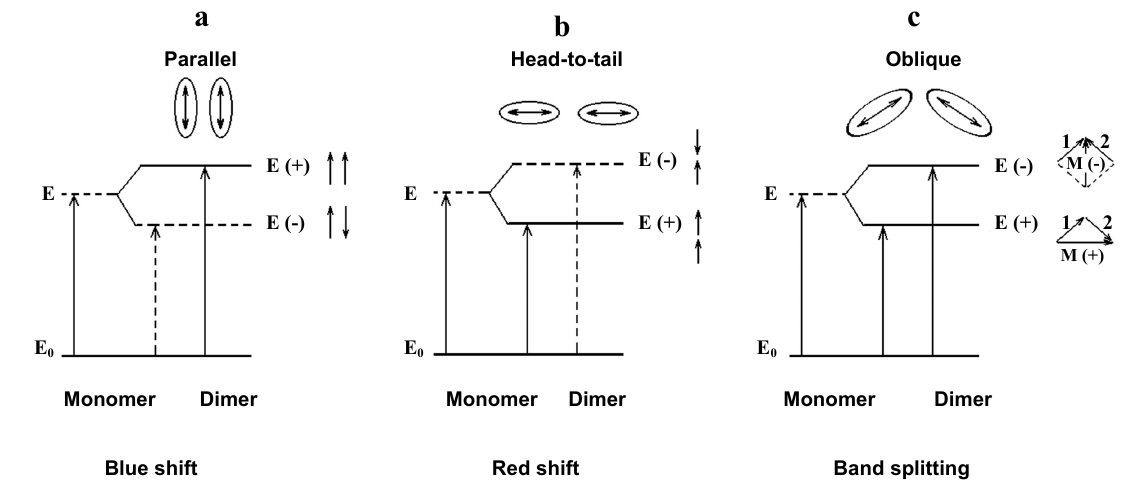
Figure 11. System of electronic energy levels and transitions from ground to excited state for dimers of different configurations: ( a ) “sandwich structure”, ( b ) “head to tail”, ( c ) location of molecules at some angle—”tree type”. Dotted arrows and lines indicate forbidden transition and their corresponding levels [19].